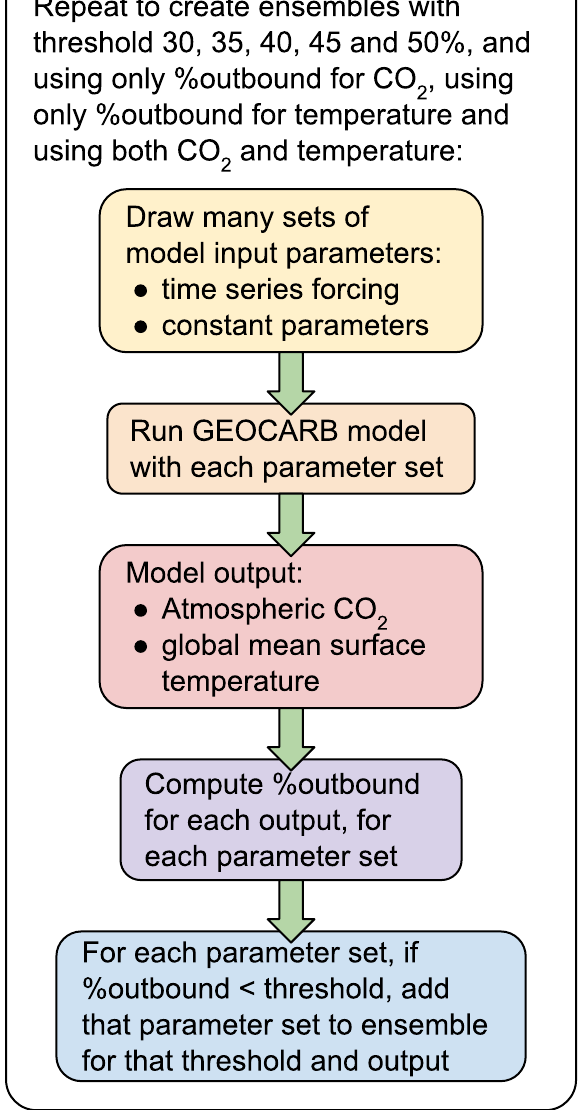
Fig. 1 Schematic of the precalibration work fl ow. This work fl ow is repeated to produce ensembles by varying the %outbound threshold and the data sets employed.